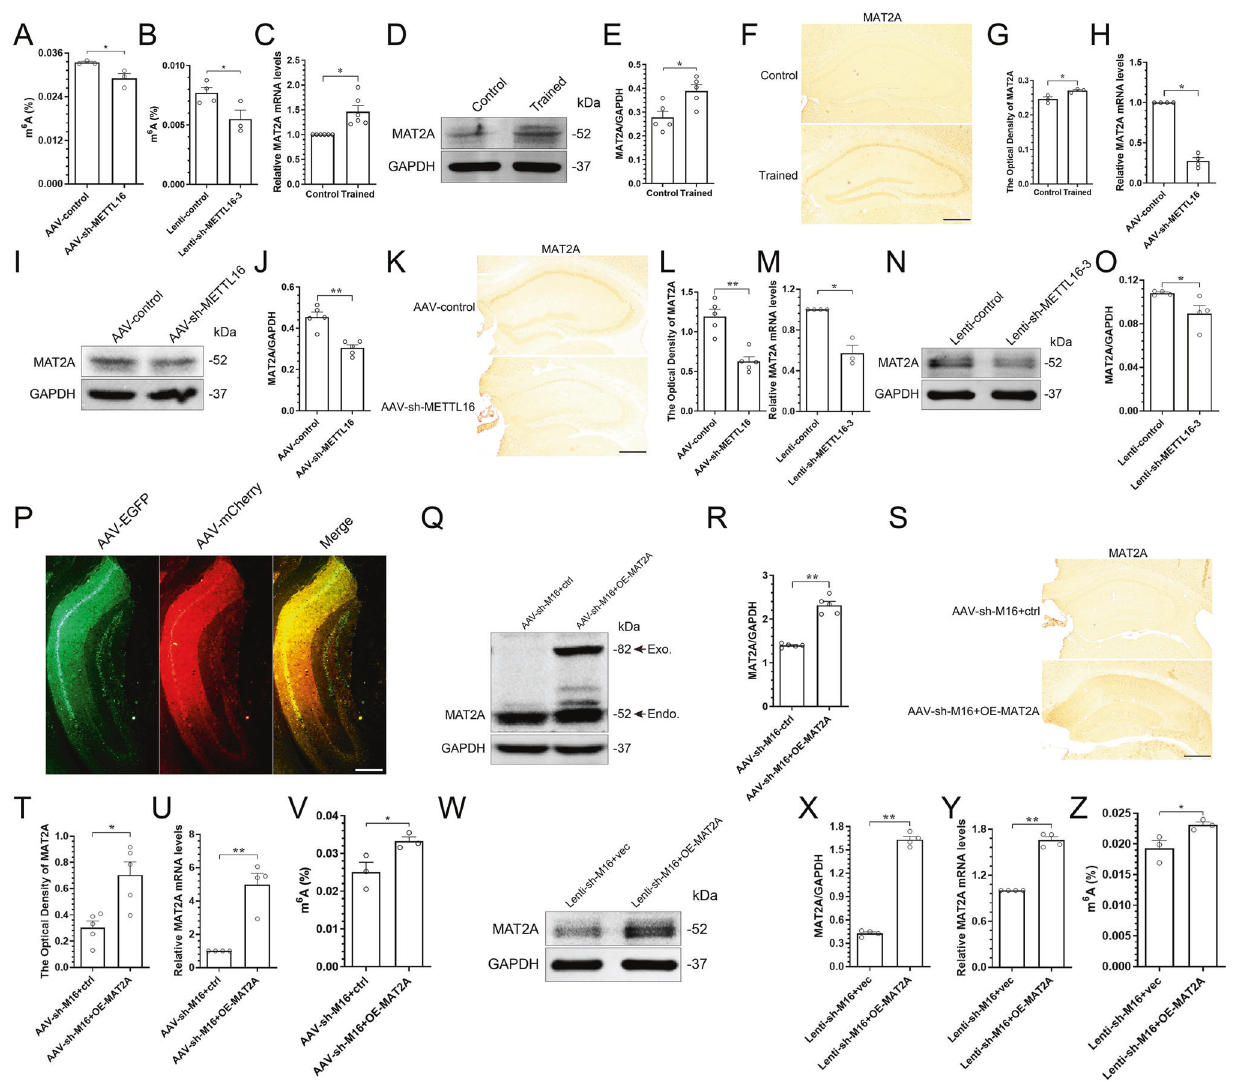
Fig. 4 Knockdown of METTL16 reduces the overall levels of m 6 A by reducing the expression of MAT2A. A Overall levels of m 6 A in the hippocampi of the AAV-control ( n = 3) and AAV-sh-METTL16 group ( n = 3) were tested by m 6 A colorimetry. B Overall levels of m 6 A in the HT22 cells of the Lenti-control group ( n = 4) and Lenti-sh-METTL16-3 group ( n = 3) were tested by m 6 A colorimetry. C Expression level of MAT2A mRNA was tested by qRT – PCR in the hippocampi of MWM-trained ( n = 6) and untrained mice ( n = 6). D , E Representative images ( D ) and quanti fi cation of MAT2A ( E ) in the hippocampi of MWM-trained ( n = 5) and untrained mice ( n = 5) tested by western blotting. F , G Representative IHC images ( F ) and quanti fi cation of MAT2A ( G ) in the hippocampi of MWM-trained ( n = 3) and untrained mice ( n = 3); Scale bars = 500 μ m. H Expression level of MAT2A mRNA was tested by qRT – PCR in the hippocampi of the AAV-control group ( n = 3) and AAV-sh-METTL16 group mice ( n = 3). I , J Representative images ( I ) and quanti fi cation of MAT2A ( J ) in the hippocampi of the AAV-control group ( n = 5) and AAV-sh-METTL16 group mice ( n = 5) tested by western blotting. K , L Representative IHC images ( K ) and quanti fi cation of MAT2A ( L ) in the hippocampi of the AAV-control group ( n = 5) and AAV-sh-METTL16 group mice ( n = 5); Scale bars = 500 μ m. M Expression level of MAT2A mRNA was tested by qRT – PCR in the HT22 cells of the Lenti-control group ( n = 3) and Lenti-sh-METTL16-3 group ( n = 3). N , O Representative images ( N ) and quanti fi cation of MAT2A ( O ) in the HT22 cells of the Lenti-control group ( n = 4) and Lenti-sh-METTL16-3 group ( n = 4) tested by western blotting. P Representative image of stereotactic injections of AAV-sh-M16 + OE-MAT2A in the hippocampi; Scale bars = 500 μ m. Q , R Representative images ( Q ) and quanti fi cation of MAT2A ( R ) in the hippocampi of the AAV-sh-M16 + ctrl group ( n = 5) and AAV-sh-M16 + OE-MAT2A group mice ( n = 5) tested by western blotting. S , T Representative IHC images ( S ) and quanti fi cation of MAT2A ( T ) in the hippocampi of the AAV-sh-M16 + ctrl group ( n = 5) and AAV-sh-M16 + OE-MAT2A group mice ( n = 5); Scale bars = 500 μ m. U Overexpression ef fi ciency of MAT2A in the hippocampi was detected by qRT – PCR ( n = 4). V Overall levels of m 6 A in the hippocampi of the AAV-sh-M16 + ctrl group ( n = 3) and AAV-sh-M16 + OE-MAT2A group mice ( n = 3) tested by m 6 A colorimetry. W , X Representative images ( W ) and quanti fi cation of MAT2A ( X ) in the HT22 cells of the Lenti-sh-M16 + vec group ( n = 4) and Lenti-sh-M16 + OE-MAT2A group ( n = 4) tested by western blotting. Y Overexpression ef fi ciency of MAT2A in the HT22 cells was detected by qRT – PCR. Z Overall levels of m 6 A in the HT22 cells of the Lenti-sh-M16 + vec group ( n = 4) and Lenti-sh-M16 + OE-MAT2A group ( n = 3) were tested by m 6 A colorimetry. Data shown as the mean ± SEM. P -values were determined by two-tailed t -test. * P < 0.05, ** P <